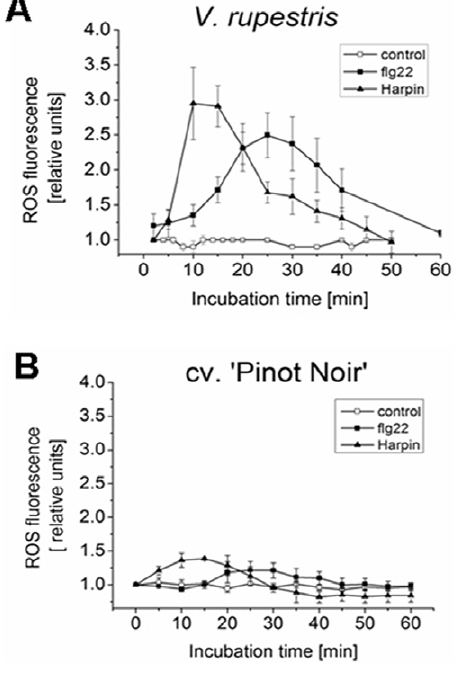
Figure 3. Production of reactive oxygen species (ROS) trig- gered by flg22 and Harpin. Time-course of ROS accumulation monitored by dihydrorhodamine 123 (DHR 123) in response to the water control (open circles), flg22 (1 m M, closed squares), or Harpin (9 m g . ml 2 1 , closed triangles) in V. rupestris ( A ) versus V. vinifera cv. ‘Pinot Noir’ ( B ). Relative fluorescence recorded at constant exposure time (100 ms) was quantified relative to the respective base fluorescence by the Image J software as described in Material and Methods.